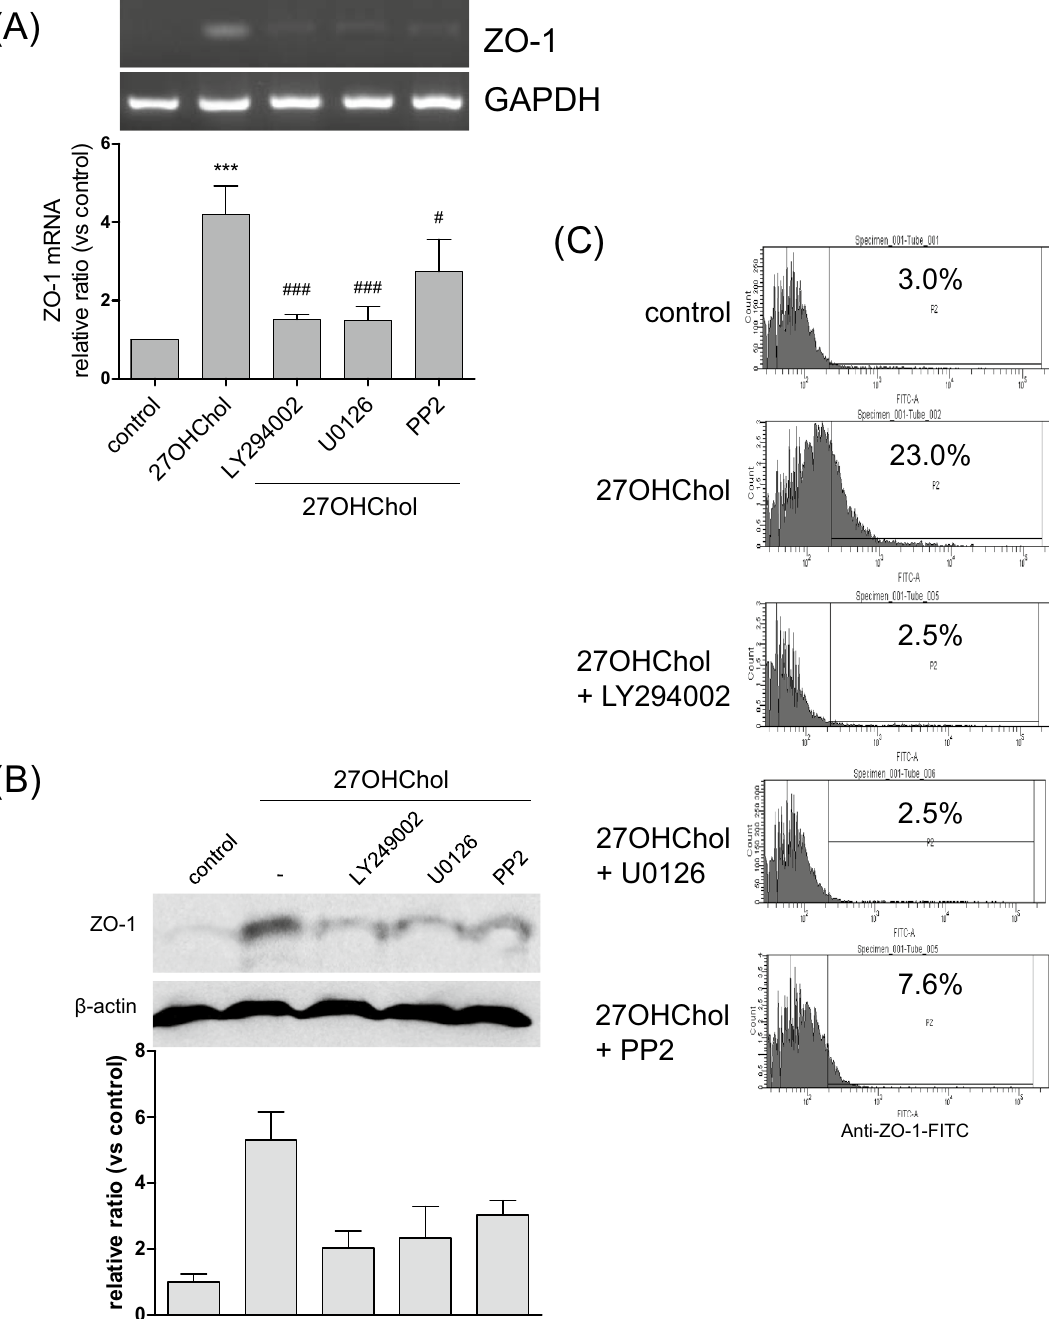
Figure 5. Effects of kinase inhibitors on the 27OHChol-induced ZO-1 expression. THP-1 cells (1 × 10 6 cells/60 mm culture dish) were treated for 2 h with the indicated inhibitors (10 μM each) and stimulated for 48 h with 2.5 µg/ml of 27OHChol. ( A ) The levels of ZO-1 transcripts were analyzed using RT-PCR and real-time PCR. The data are expressed as the mean ± SD (n = 3 replicates/group). *** P < 0.01 versus control; ### P < 0.01 versus 27OHChol; # P < 0.1 versus 27OHChol. ( B ) Total proteins obtained from the cells were analyzed via Western blot to detect ZO-1. ( C ) The ZO-1 protein on the cell surfaces was analyzed by flow cytometry. The results are representative of three independent